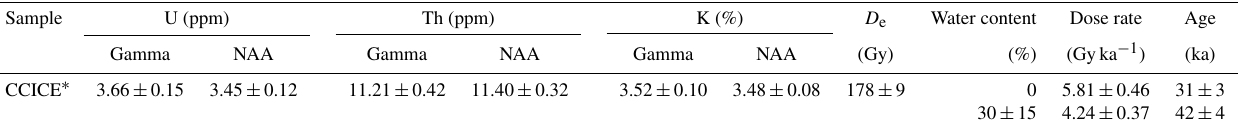
Table 1. Results of the fine quartz grains with their corresponding OSL ages. Sample